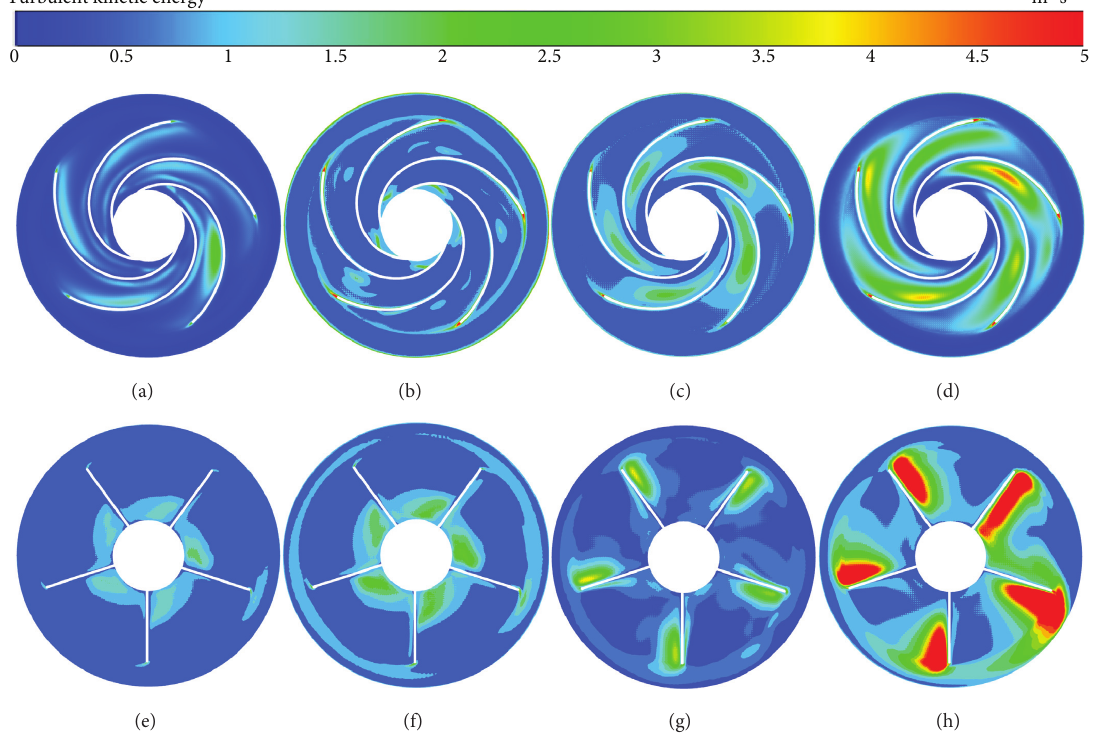
Figure 11: TKE distribution at Z 2 characteristic section. (a) S 1 . (b) S 2 . (c) S 3 . (d) S 4 . (e) S 5 . (f) S 6 . (g) S 7 . (h) S 8 .